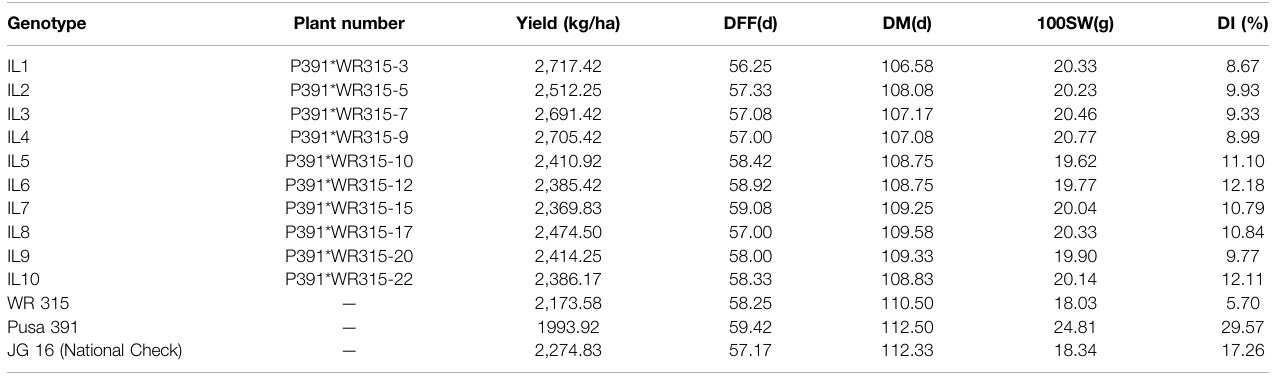
TABLE1| Meanyield-Yieldperformance(Kg/ha),daystoFiftypercentFlowering(DFF),daystomaturity(DM),100SeedWeight(HSW)anddiseaseIndex(DI)ofchickpeaat six locations during 2017 – 2018. Genotype Plant number